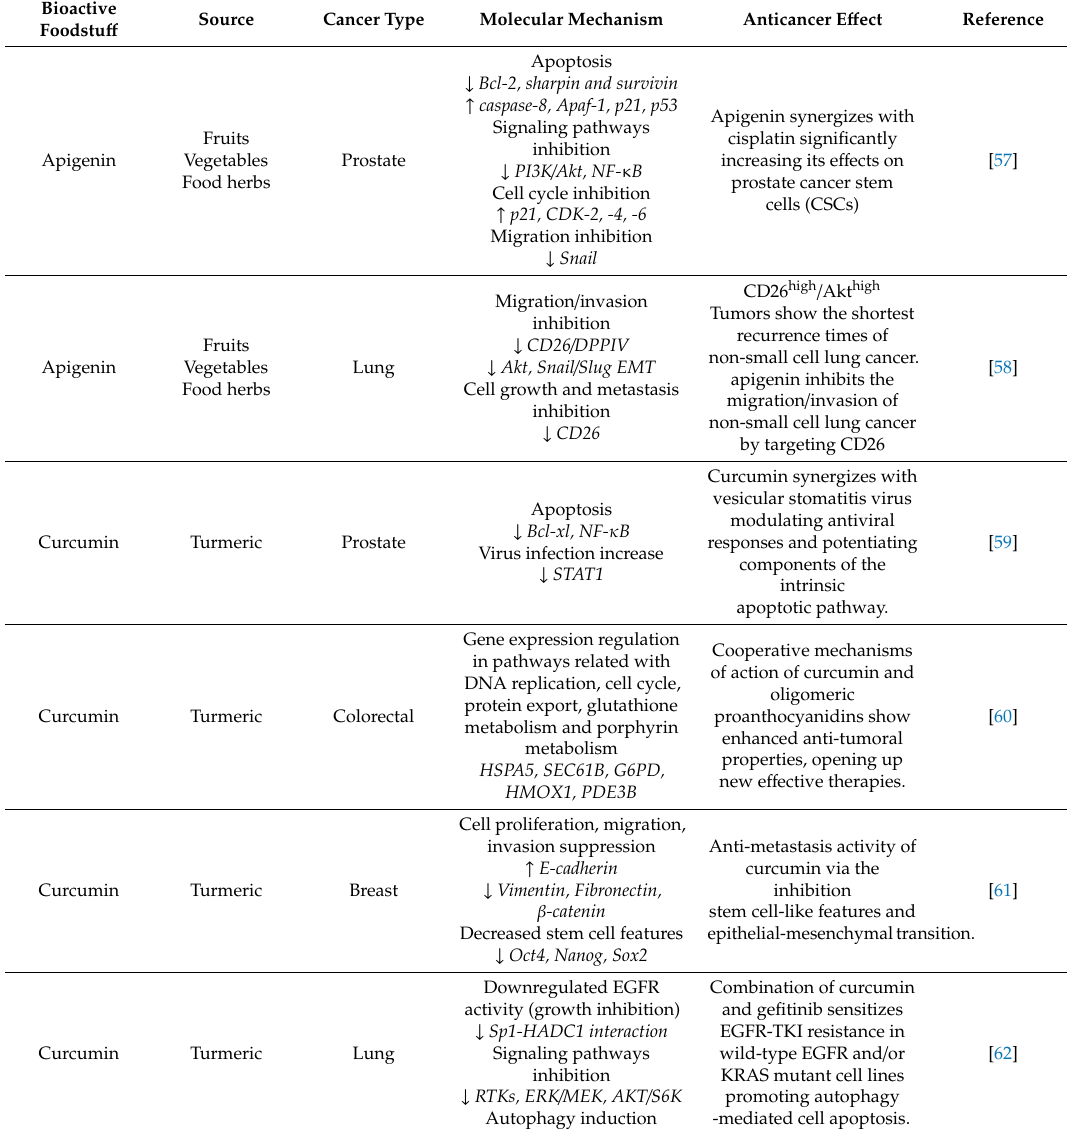
Table 2. Characteristics of included studies related to polyphenol foodstu ff s. Results are alphabetically sorted by bioactive foodstu ff . Molecular mechanisms are summarized indicating inhibition ( ↓ ) or activation ( ↑ ) regarding either gene expression, signaling pathways, protein stability, or protein post-translational modifications. Regulated targets are shown in